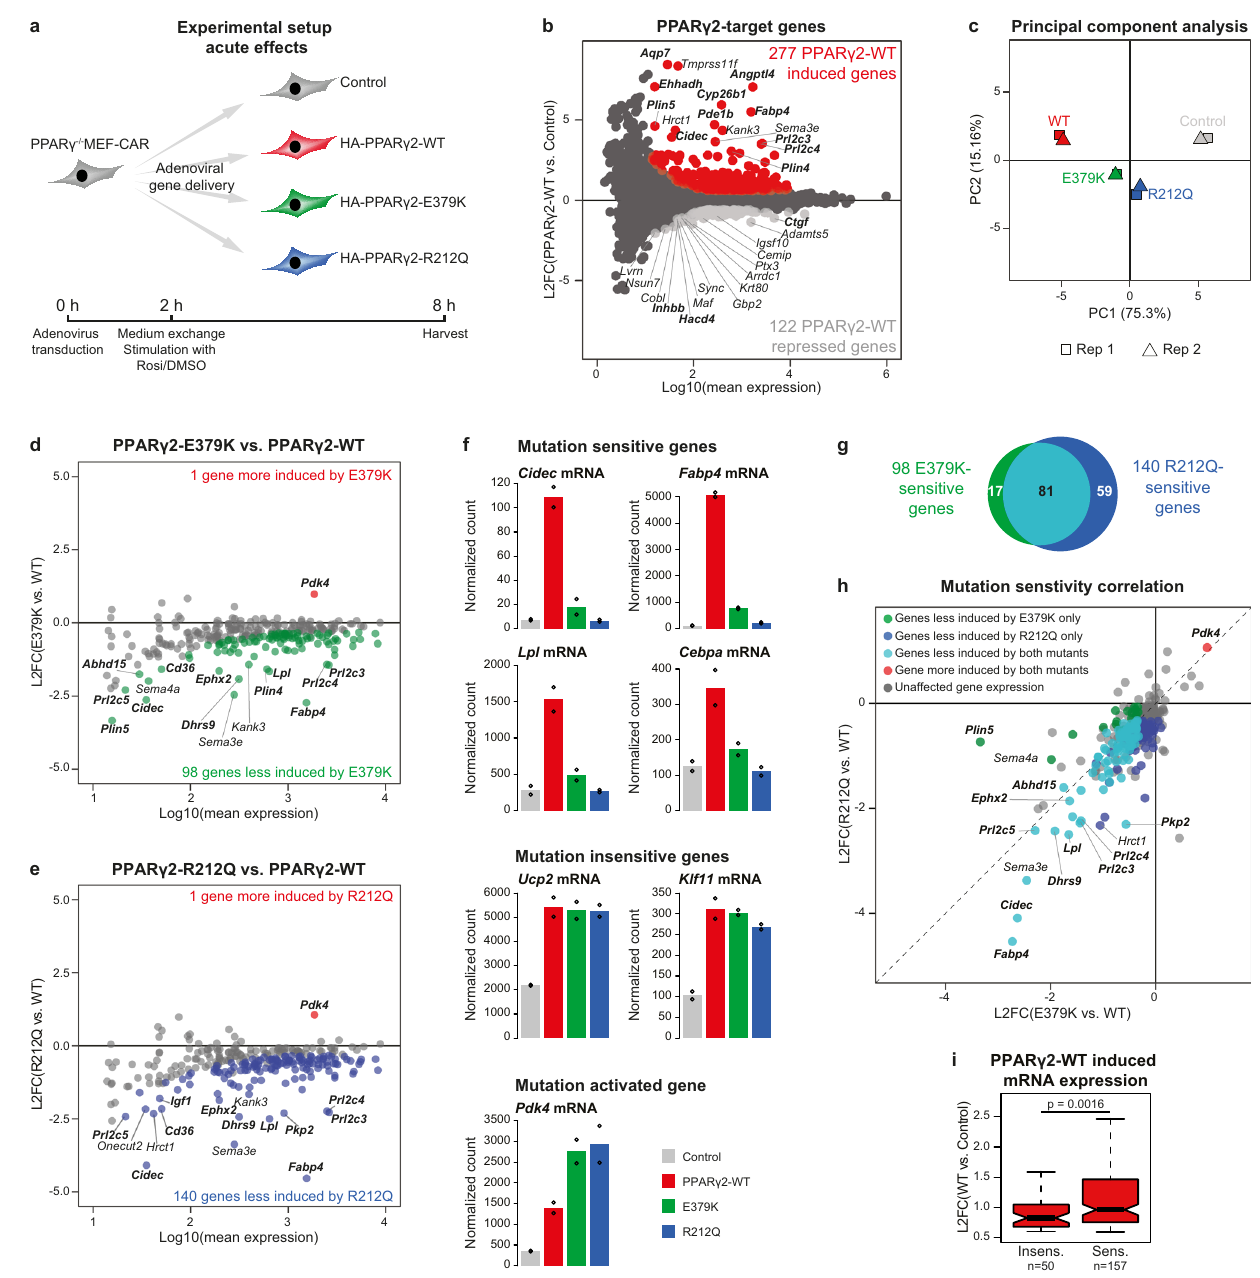
Fig. 5 | The E379K and R212Q mutants display partial deregulation of PPAR γ - target genes. a Experimental outline showing the timing of virus transduction, ligand stimulation (1 µ M Rosiglitazone) and harvest of PPAR γ − / − MEF-CAR cells to investigate acute transcriptional changes upon introduction of WT and mutant PPAR γ 2s. b Identi fi cation of PPAR γ 2-target genes from RNA-seq data. PPAR γ 2-WT induced (reddots) and repressed(light graydots) genes are de fi ned using DESeq2 with Benjamini – Hochberg correction (padj. <0.05, two-sided) and increasing or decreasingbyafoldchange>1.5comparedtocontrolcells,respectively.Blackdots represent unaffected genes. L2FC, log2 fold change. Top-15 most induced and repressed genes are indicated, with genes known to be involved in adipocyte biology marked in bold. c Variance in RNA-seq data ( n =2 independent biological experiments). Identi fi cation of d E379K-sensitive and e R212Q-sensitive PPAR γ 2- target genes. Red dots represent genes more induced by mutant compared to WT PPAR γ 2 (padj.(mut vs. WT)<0.05, FC (mut vs. WT)>1.25). Green and blue dots represent genes less induced by E379K and R212Q compared to WT, respectively (padj.(mut vs. WT)<0.05, FC (mut vs. WT)< − 1.25). Statistical signi fi cance was